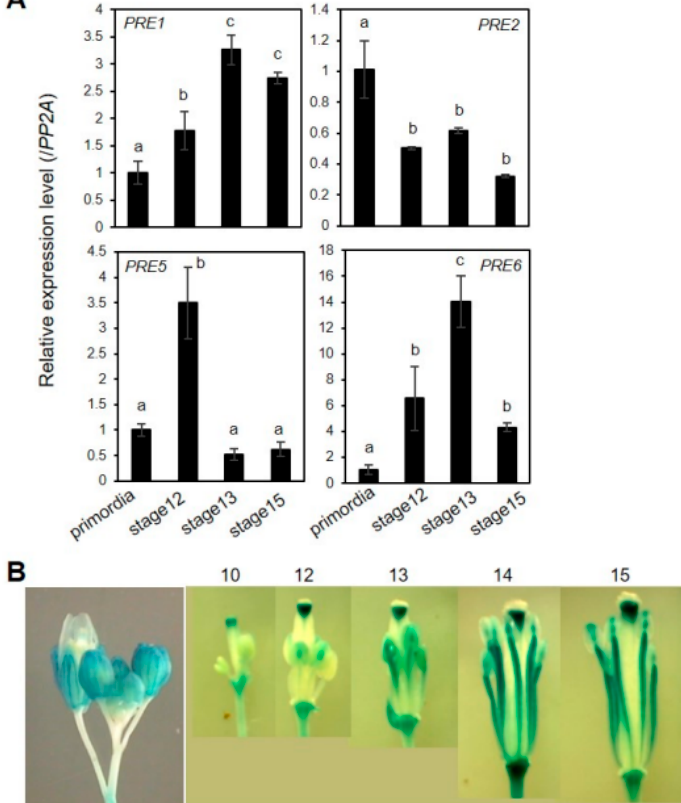
Figure 5. Expression of PRE genes during flower maturation. ( A ) Quantitative RT–PCR analyses of gene expression of PREs in developing flowers. Total RNAs were isolated from flowers at specific flower developmental stages. The data was represented as a relative value to primordia that was set to 1. The PP2A gene was used as an internal control. Values are mean ± SD from three technical replicates. Significant difference among flower development stages is indicated with letters (ANOVA, Tukey HSD test, p < 0.05). ( B ) PRE6 pro: GUS analysis. PRE6 promoter activity was monitored by GUS staining of transgenic plants expressing PRE6 pro: GUS at indicated flower developmental stages.